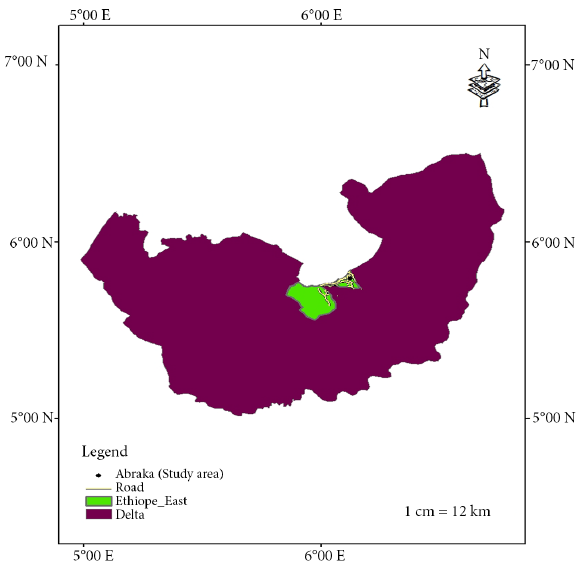
Fig. 1. Map of Delta state showing the study